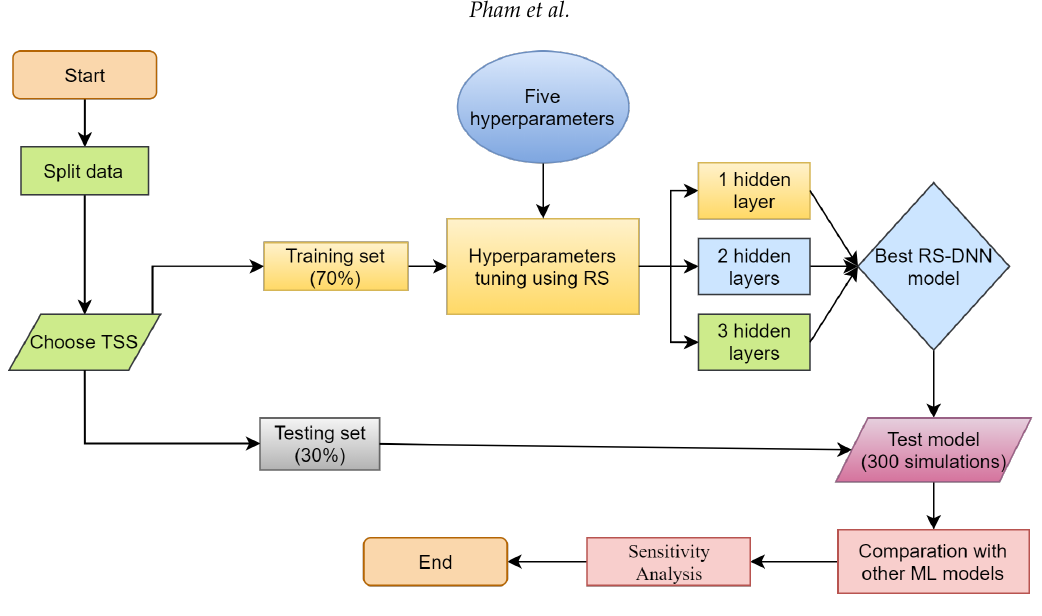
Fig. 3. Methodology flow chart of this